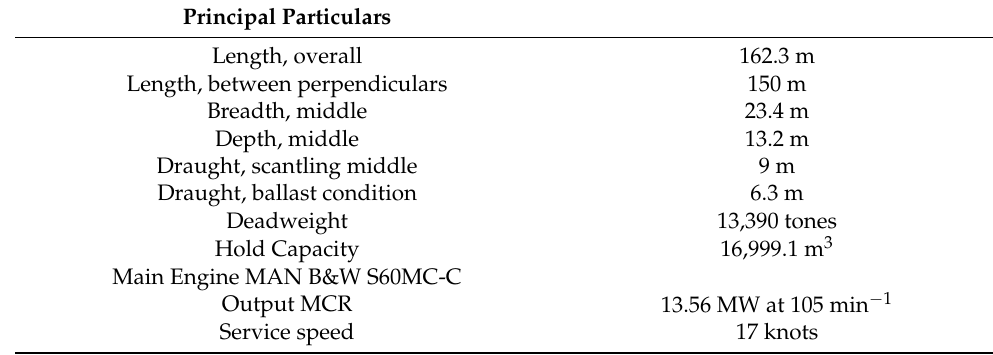
Table 1. The model ship principal particulars.